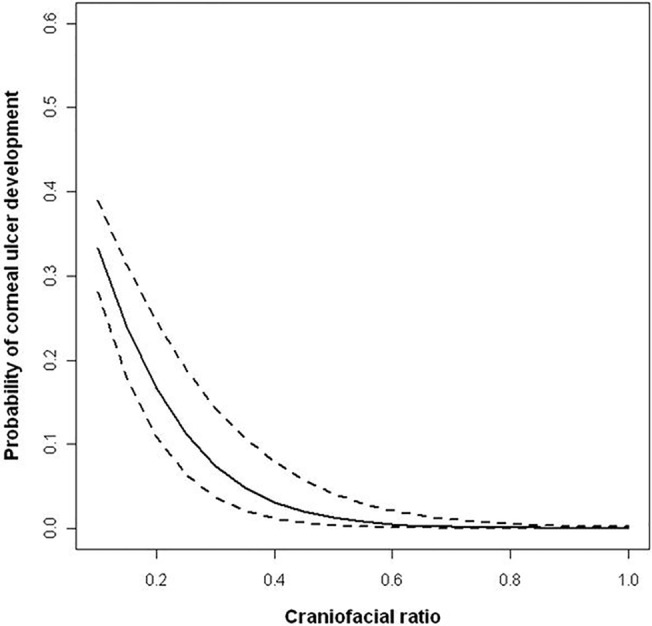
Probability of being affected by a corneal ulcer across the craniofacial ratio spectrum.The curve is generated from a generalised linear mixed model with craniofacial ratio as a single continuous factor to examine its effect on ulcer risk in isolation. As craniofacial ratio increases (and muzzles become relatively longer), corneal ulcer risk decreases.